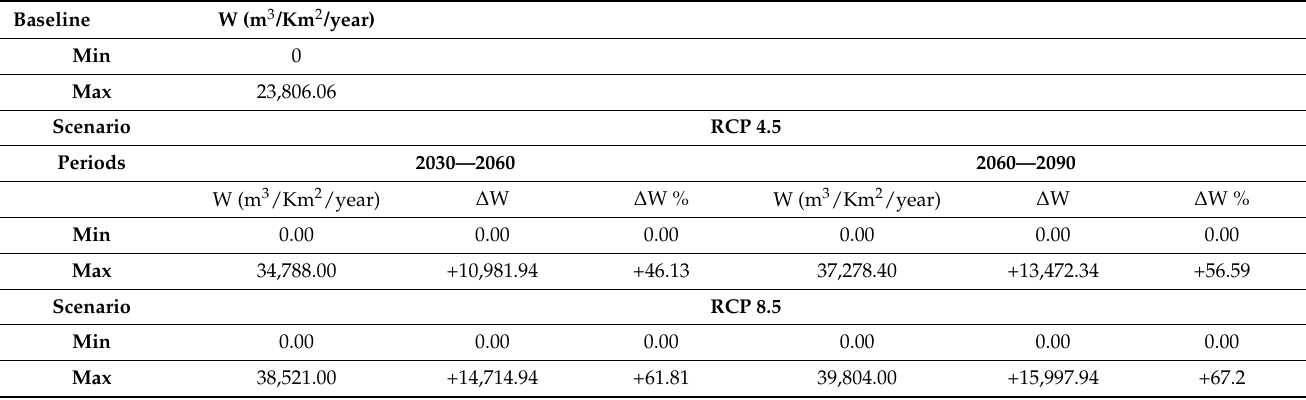
Table 7. The minimum, maximum, and average values of expected soil